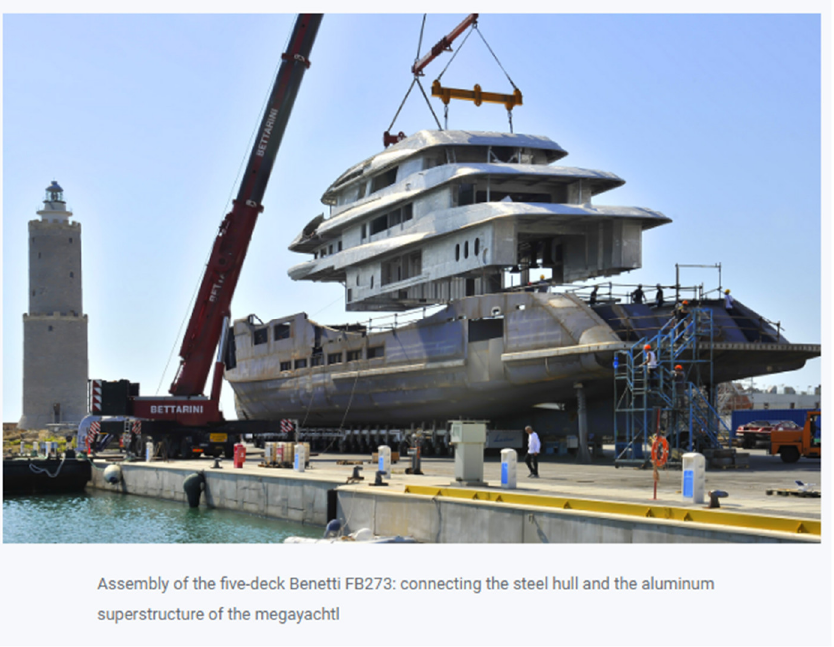
Figure 24. Welding steel hull to Al superstructure [134]. Accessed date 26 February 2022.